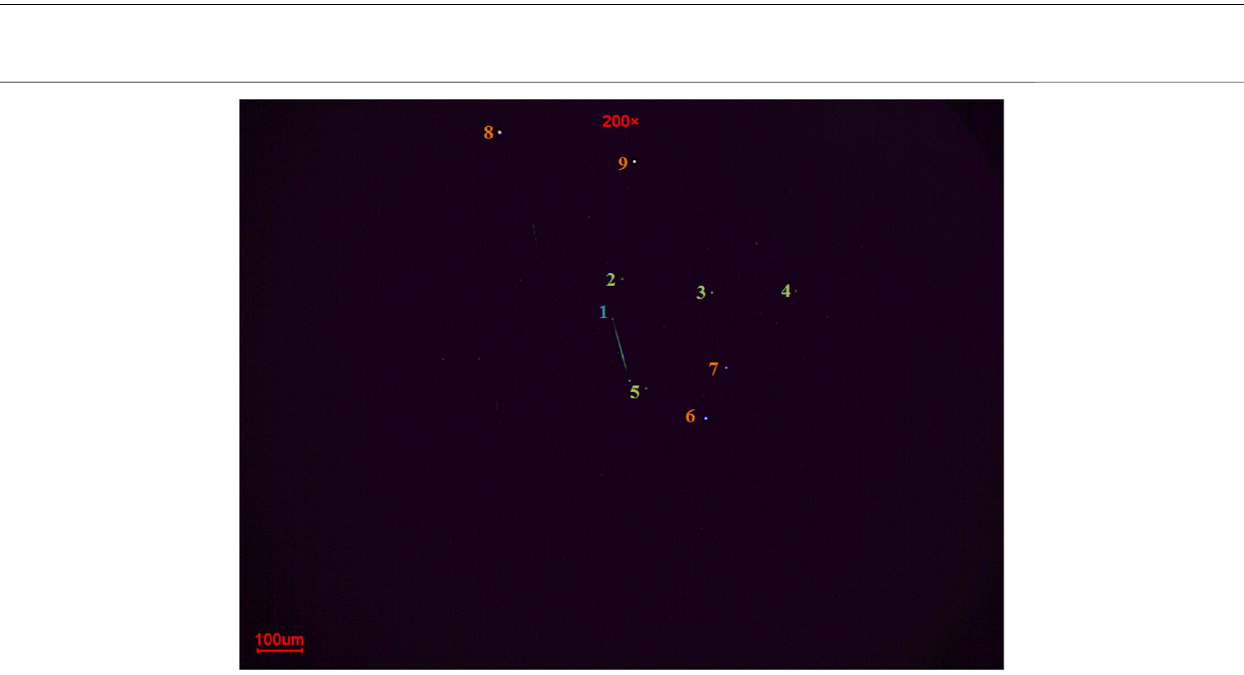
FIGURE 8 | Sub- fi eld testing results from cosmetic defects using a dark- fi eld microscope.